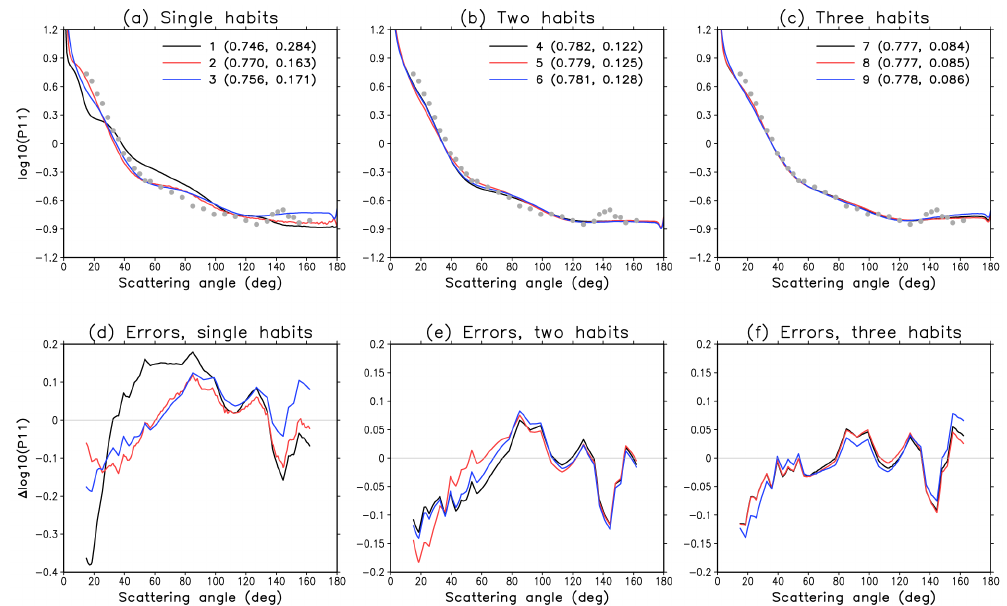
Figure 4. Comparison of modelled phase functions with the reference phase function ( P ref shown with grey dots in a–c ). (a) Selected single- 11 habit cases: 1 = distorted Koch fractals with t = 0.18; 2 = Gaussian spheres with σ = 0.30, ν = 1.5 and n max = 15; and 3 = aggregates of eight severely rough (SR) columns. (b) Best combinations of two habits: 4 = aggregates of eight SR columns and SR hollow bullet rosettes (weights 0.61 and 0.39); 5 = aggregates of eight SR columns and aggregates of five SR plates (weights 0.61 and 0.39); and 6 = aggregates of eight SR columns and SR hollow columns (weights 0.68 and 0.32). (c) Best combinations of three habits: 7 = SR droxtals, SR hollow columns and distorted Koch fractals ( t = 0.50) (weights 0.32, 0.30 and 0.38); 8 = SR droxtals, SR hollow bullet rosettes and distorted Koch fractals ( t = 0.50) (weights 0.26, 0.36 and 0.38); and 9 = SR droxtals, aggregates of 10 SR plates and distorted Koch fractals ( t = 0.50) (weights 0.36, 0.26 and 0.38). In the legends in (a–c) , the two numbers in parentheses give the asymmetry parameter and the cost function defined by Eq. (4) respectively. (d–f) show the corresponding differences from P ref 11